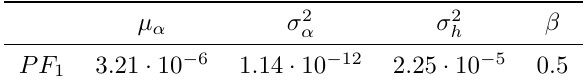
Table 2: Initial PF parameter values for test rig 2 ex- periment.